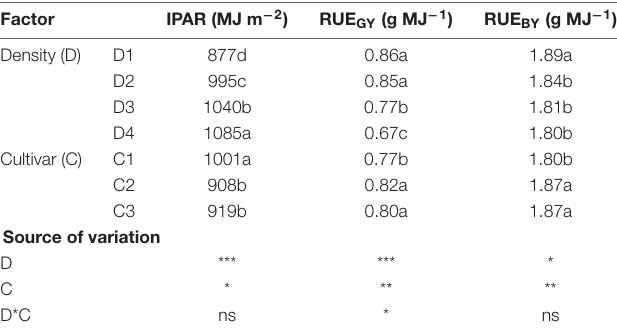
TABLE 3 | Intercepted photosynthetically active radiation (IPAR) and radiation use efficiency (RUE) of dryland maize in different treatments.